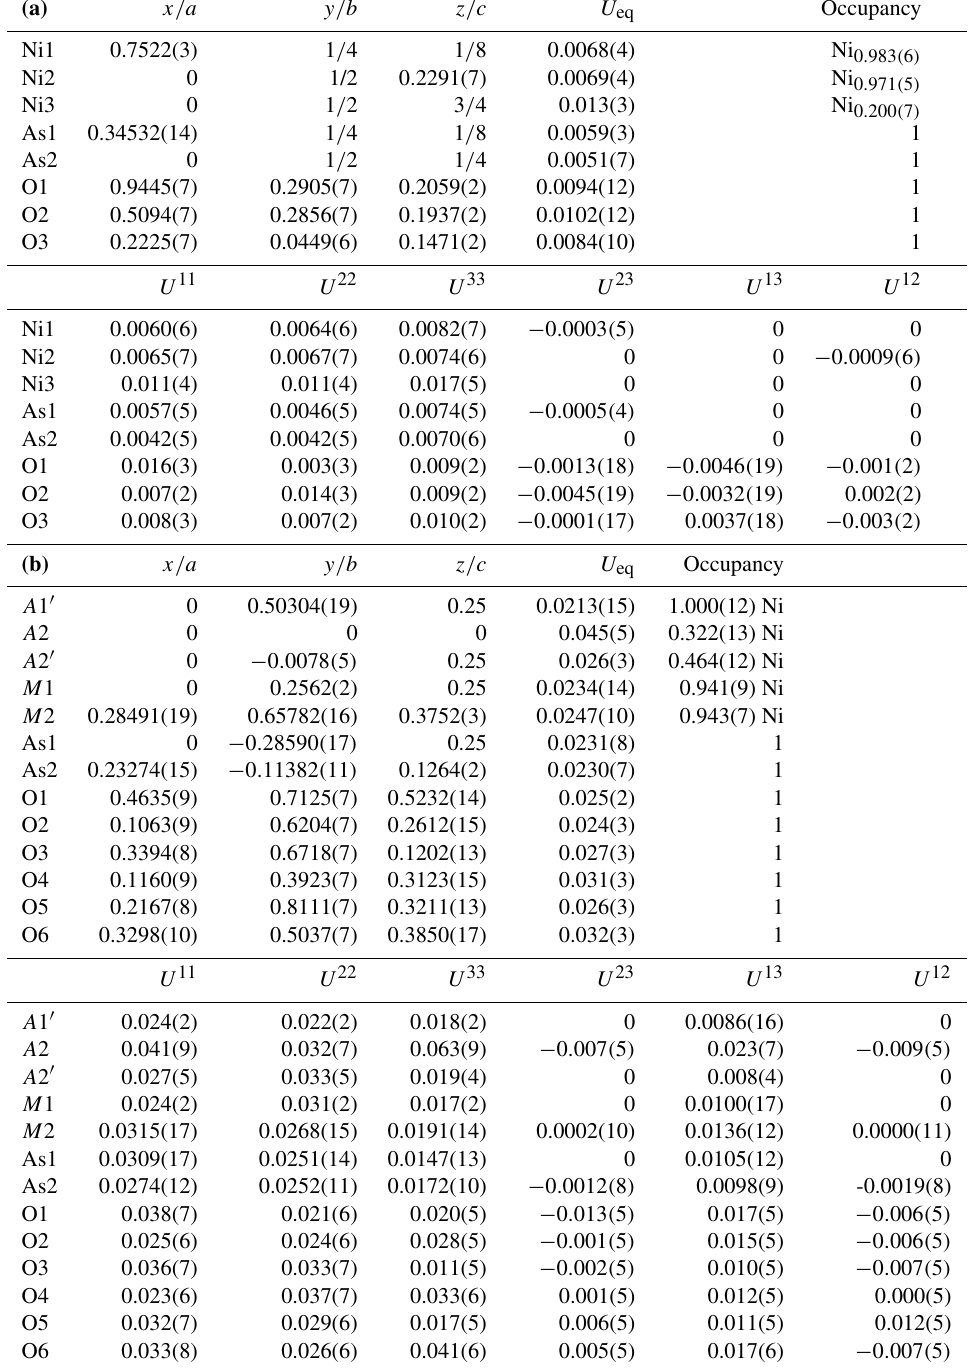
Table 4. (a) Atom coordinates and displacement parameters (Å 2 ) for niasite. (b) Atom coordinates and displacement parameters (Å 2 ) for